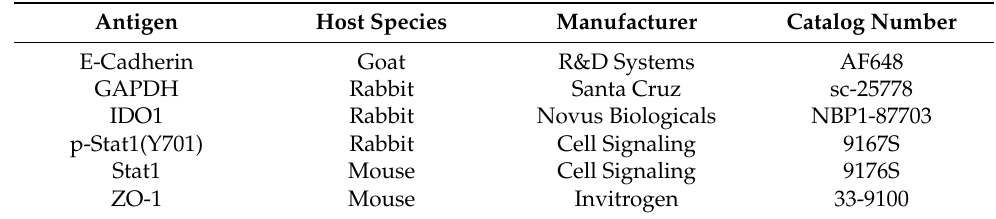
Table 2. Primary antibodies for immunocytochemistry and Western